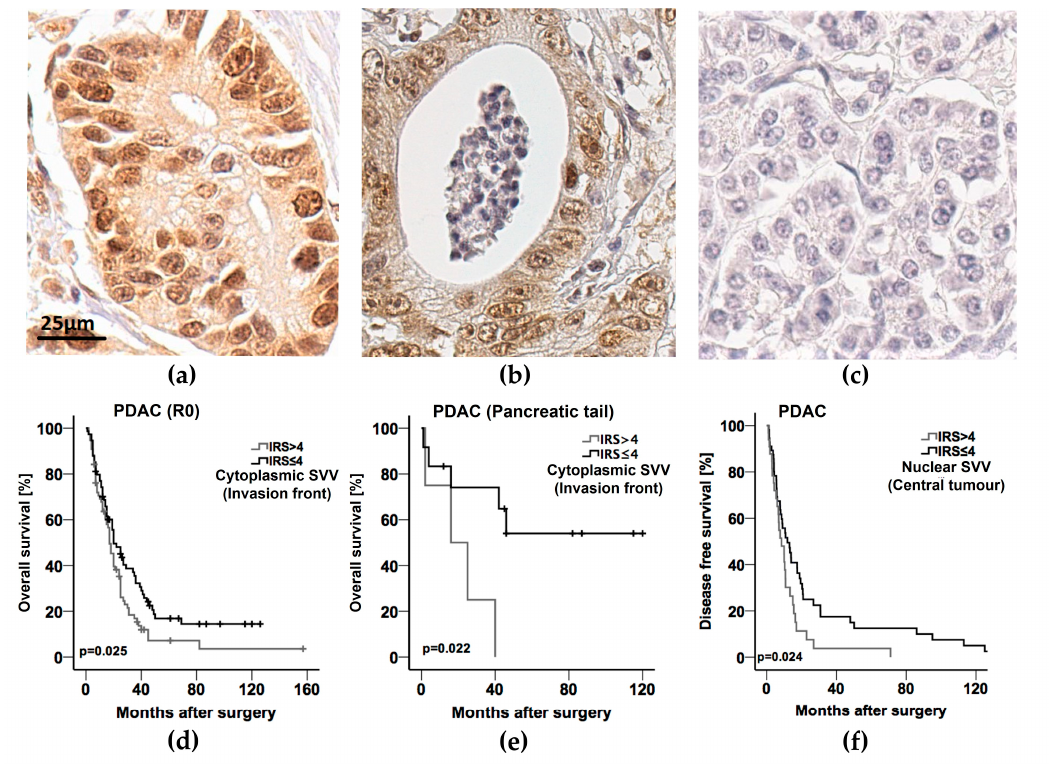
Figure 2. ( a ) Representative image of pancreatic ductal adenocarcinoma (PDAC) with an im- munoreactivity score (IRS) of 4/12 for survivin expression in the central area of the tumour sample at 400 × magnification. Scale bar indicates 25 µ m. ( b ) Representative image of a PDAC lymph node metastasis with an IRS of 4/12 for survivin expression at 400 × magnification. ( c ) Representative image of non-neoplastic pancreatic tissue with an IRS of 0/12 negative for survivin expression at 400 × magnification. ( d ) Kaplan–Meier curve for overall survival of all R0 resected patients with PDAC of the pancreatic head and tail in correlation with cytoplasmic survivin expression at the invasion front ( p = 0.025 as calculated by log rank test (SVV—survivin; IRS—immunoreactivity score). ( e ) Kaplan–Meier curve for overall survival of all patients with PDAC of the pancreatic tail in correlation with cytoplasmic survivin expression at the invasion front ( p = 0.022 as calculated by log rank test) (SVV—survivin; IRS—immunoreactivity score); ( f ) Kaplan–Meier curve for disease-free survival of all patients with PDAC in correlation with nuclear survivin expression in central tumour areas ( p = 0.024 as calculated by log rank test) (SVV—survivin; IRS—immunoreactivity